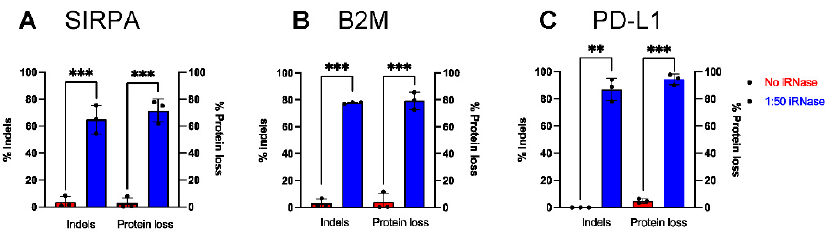
Figure 4. iRNase enhanced Cas9 mRNA mediates various gene KO in monocytes. Percent of monocytes with indels, as measured by TIDE analysis, or loss of protein expression, as measured by flow cytometer following electroporation with Cas9 and gRNAs targeting either ( A ) SIRPA ( B ) B2M and ( C ) PD-L1 in the presence (Blue) or absence of iRNase (Red). Statistical analyses were performed using Student’s t-test (n = 3 independent biological donors) (** p < 0.01, *** p < 0.001).